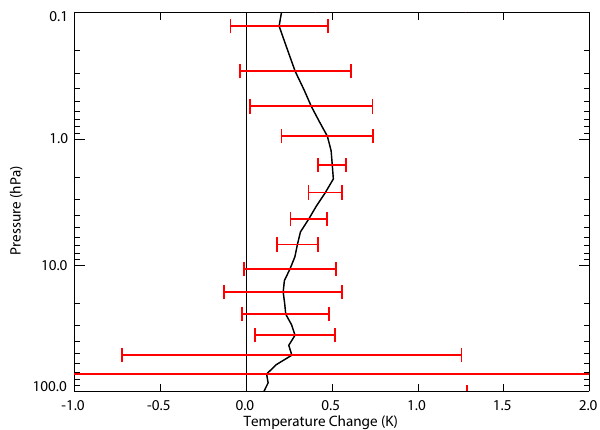
Fig. 3. Annual average temperature change (K) over the solar cycle (solar maximum minus solar minimum) between 100 and 0.1hPa in WACCM4a, averaged over the latitude band 25 ◦ S–25 ◦ N. Red error bars denote the 2 σ uncertainty. For emphasis, we show the zero temperature change by the vertical black solid line. Fig. 4. (a) Wavelet power spectrum of the QBO at 30hPa, show- Table 1. The mean and standard deviation of the QBO amplitude ing the dominant period of the QBO and its variability with time and duration for both east and west phases in WACCM4a as a func- through the entire WACCM4a simulation. Color shading denotes tion of solar maximum (Max) and solar minimum (Min) years. the power. Bottom x axis denotes the time (years) and left y axis corresponds to the period (in months) of the QBO. Yellow solid Amplitude (ms − 1 ) Duration (months.) contours enclose regions greater than 95% confidence. Wavelet software provided by C. Torrence and G. Compo, is available at http://paos.colorado.edu/research/wavelets/. More information on wavelet analysis is provided in Torrence and Compo (1998). (b) The annually averaged 255nm spectral irradiance (red solid line) from Lean et al. (2005), along with the variation in the QBO dura- tion in months (blue dashed line) in WACCM4a. The variation in the QBO period is determined from the wavelet power spectrum, as described in Sect. 3. Yellow line denotes the average QBO period over the entire model simulation (27.2